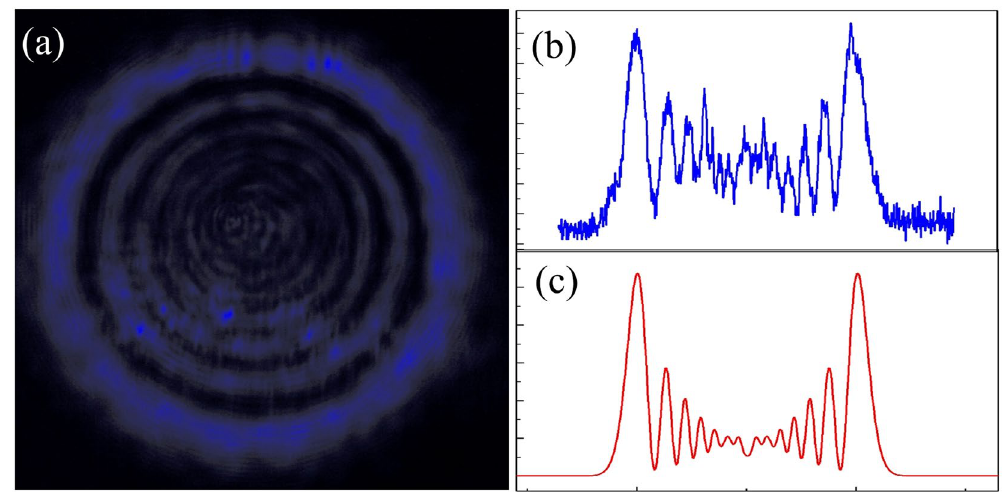
Figure 3. ( a ) The diffraction rings irradiated by 1061 nm ultrafast laser; ( b ) The axial intensity distribution of ( a ); and ( c ) The corresponding simulated intensity